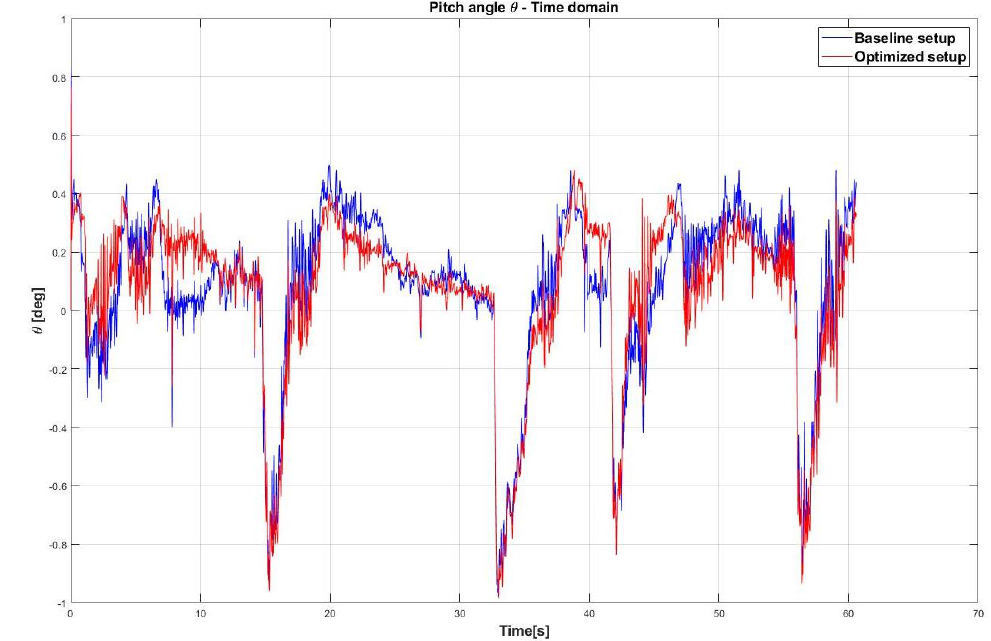
Figure 22. Comparison between the baseline provided setup and improved setup for the pitch angle trend in the time